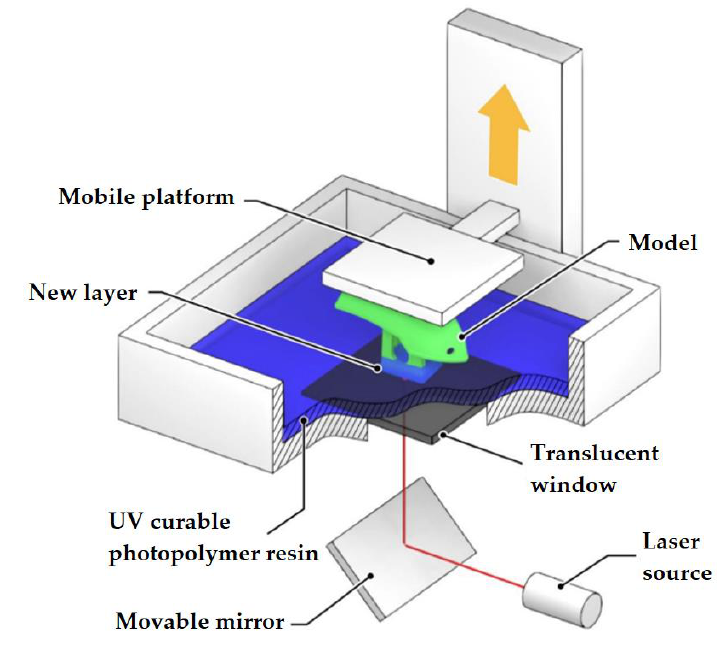
Figure 4. SLA method .